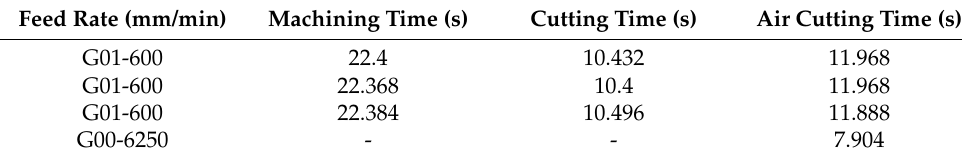
Table 3. Monitoring result based on vibration judgment. Figure 6. G01 cutting time and machining time monitoring result.